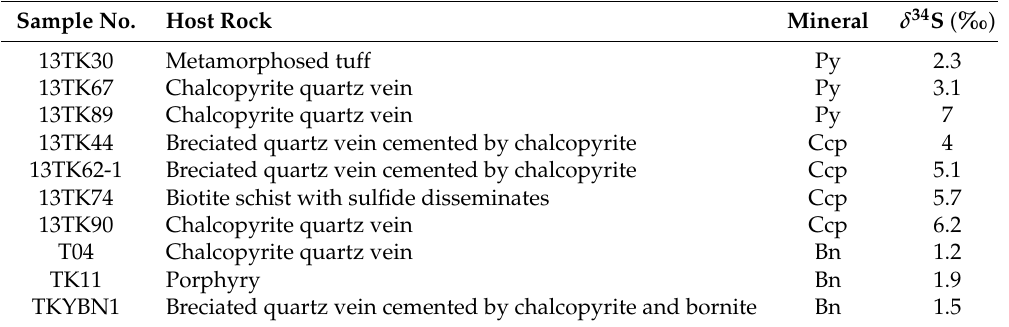
Table 5. Sulfur isotopic composition of sulfides of the Tongkuangyu Cu deposit, North China Craton. Sample